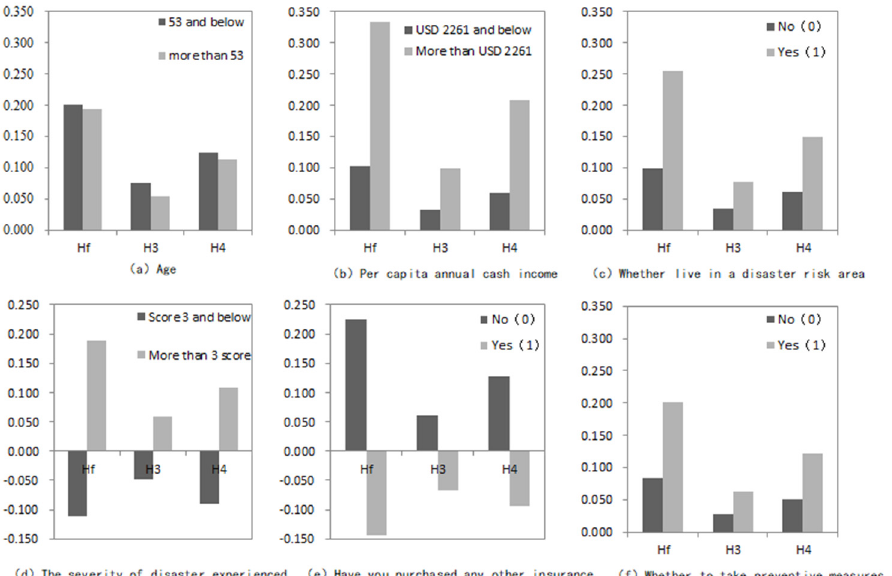
Figure 4. Heterogeneity analysis results.